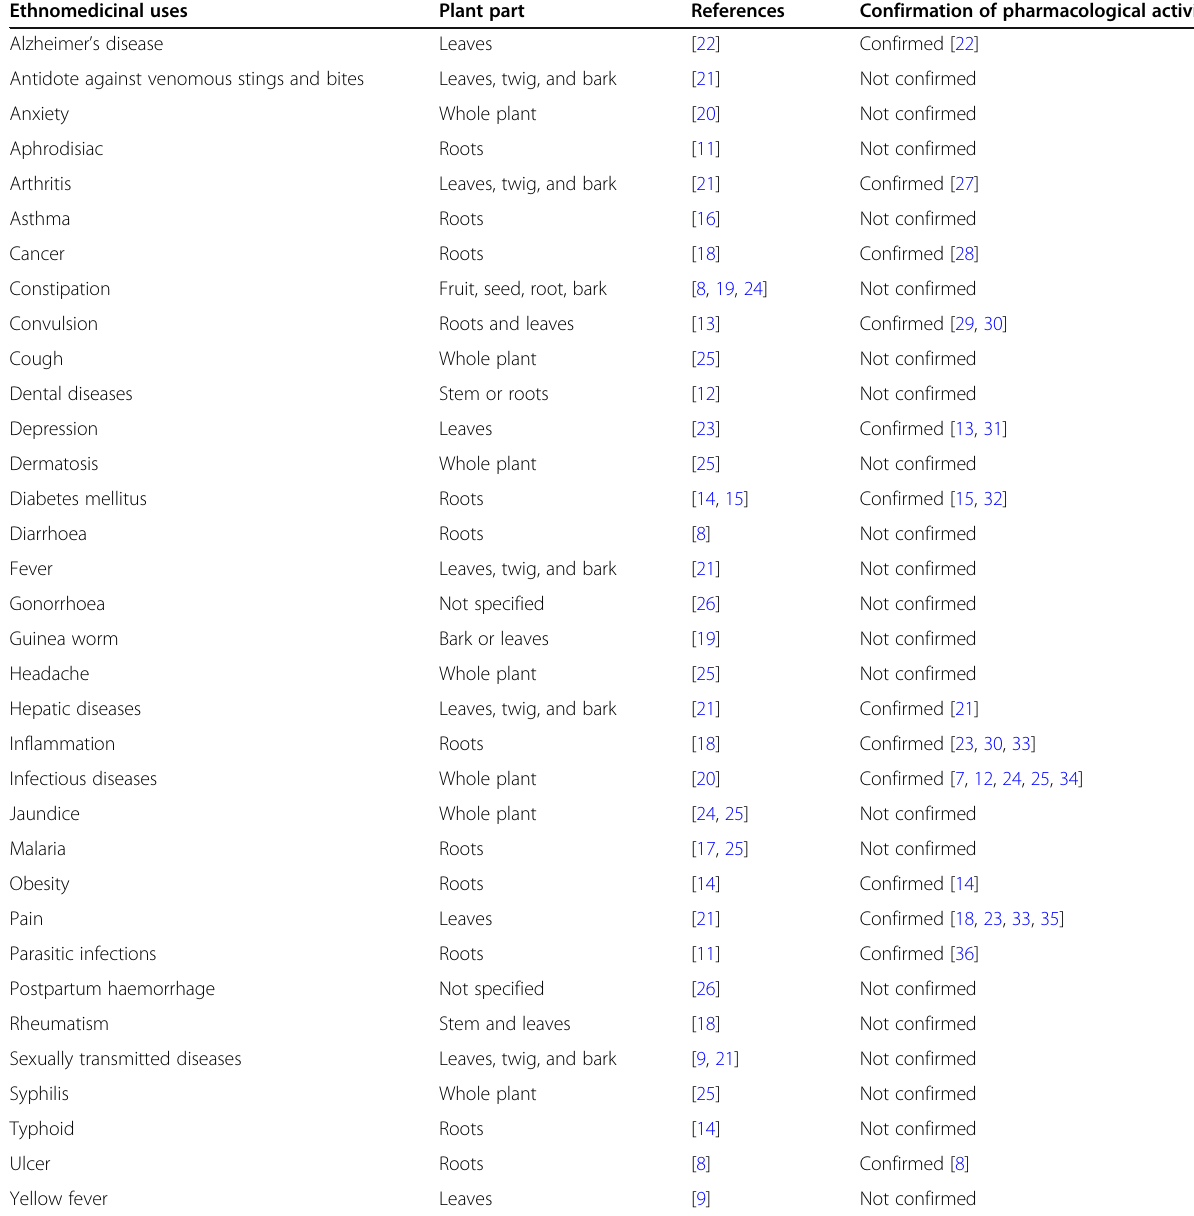
Table 1 Ethnopharmacological uses of Olax subscorpioidea and scientific confirmation of their pharmacological activity Ethnomedicinal